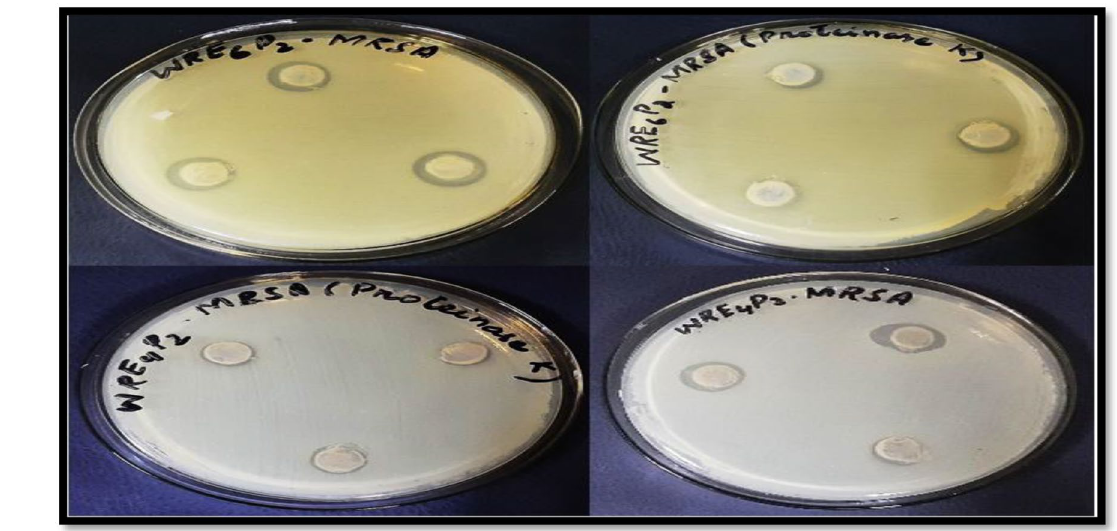
Fig. 4 Effect of proteinase K on bacteriocins